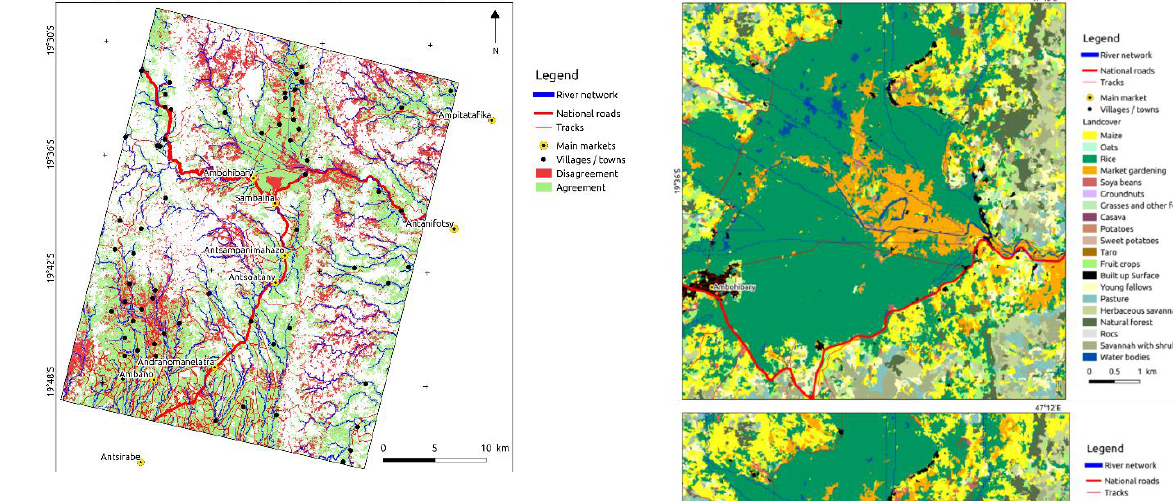
Figure 3. Map showing the disagreements between rule-based (CMVPrule) and remote sensing-based (CMVPsat) class assignment for rice, maize and market gardening.